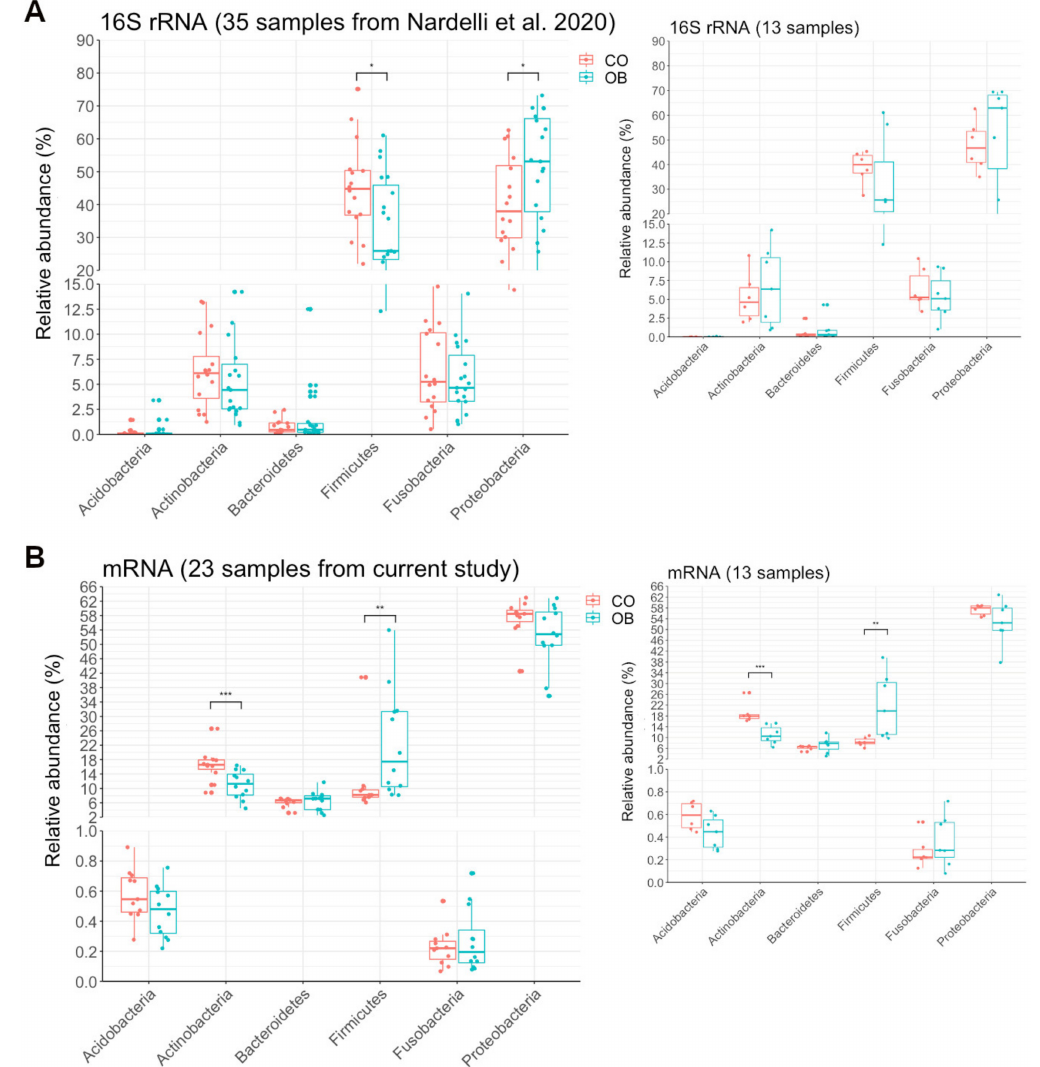
Figure 3. Phyla abundances in Obese (OB) and Lean (CO) subjects obtained by 16S rRNA sequencing and inferred from transcriptomic data. The boxplots show the relative abundances of phyla obtained through 16S shotgun sequencing performed in our previous study (Nardelli et al., 2020) ( A ) and inferred by the mRNA gene abundances in the current study ( B ), containing 35 and 23 samples, respectively. Among these, 13 patients (6 CO and 7 OB) were analyzed in terms of both 16S rRNA and transcriptomics and are shown by the right smaller plots. The middle line in the boxes represents the median, lower box bounds represent the first quartile, and upper box bounds represent the third quartile. Whiskers represent the 95% confidence interval of the mean. The significance of distribution di ff erences was calculated by applying the Kruskal–Wallis test and Benjamini-Hochberg p -value adjustment (* p < 0.05; ** p < 0.01; *** p < 0.005). The Red and Cyan boxplots indicate control and obese samples,